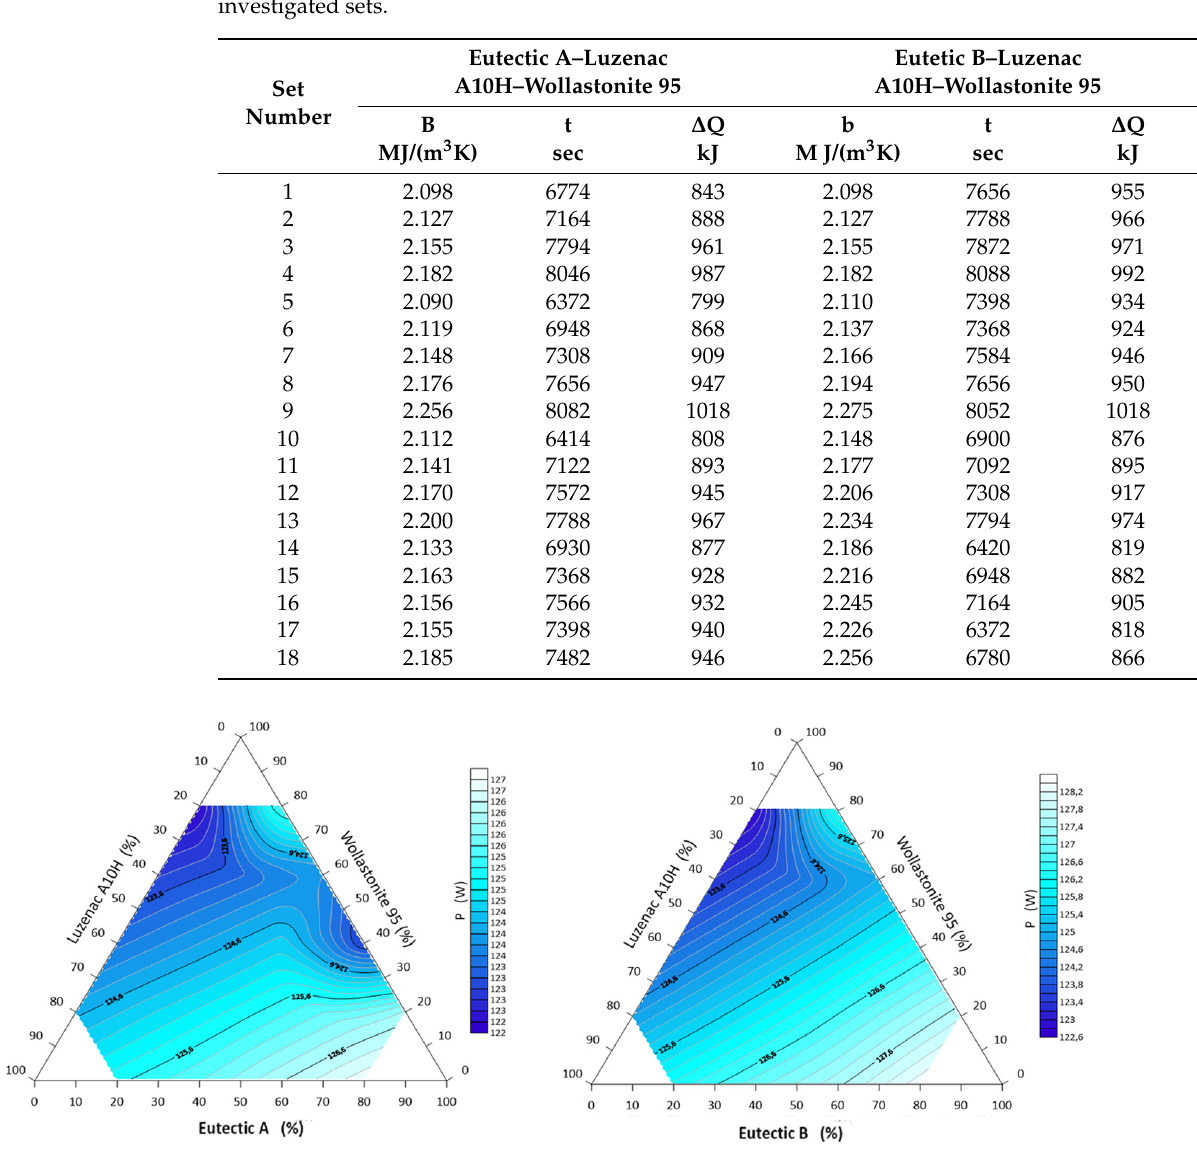
Figure 7. Thermal power P of three-component mineral system Eutectic A/B–Luzenac A10H–Wollastonite 95.